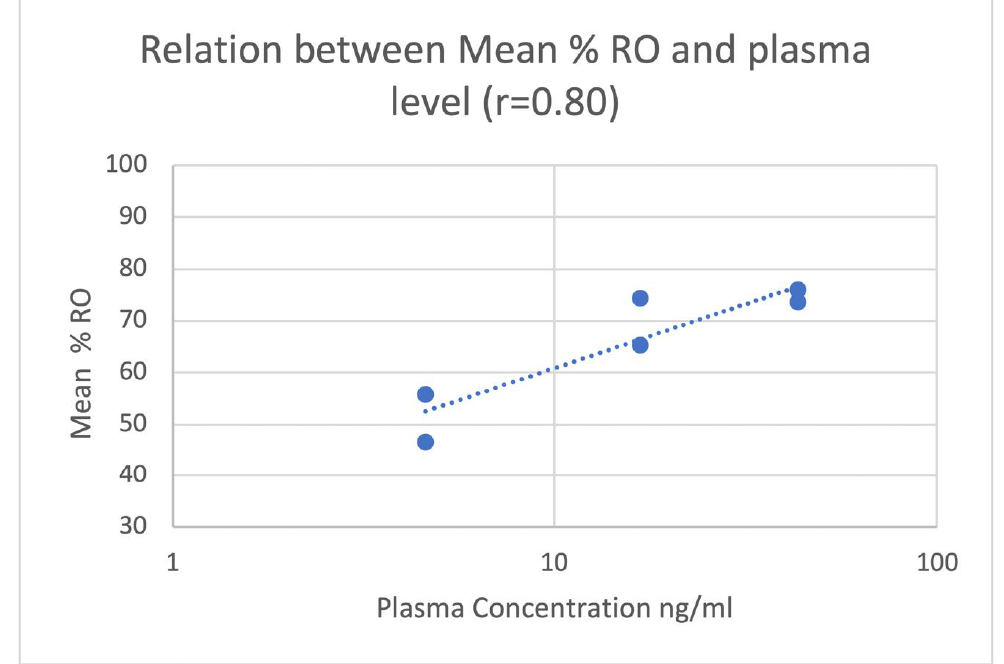
Figure 4. The relationship (r = 0.80) between NLX plasma level and RO in the basal ganglia and